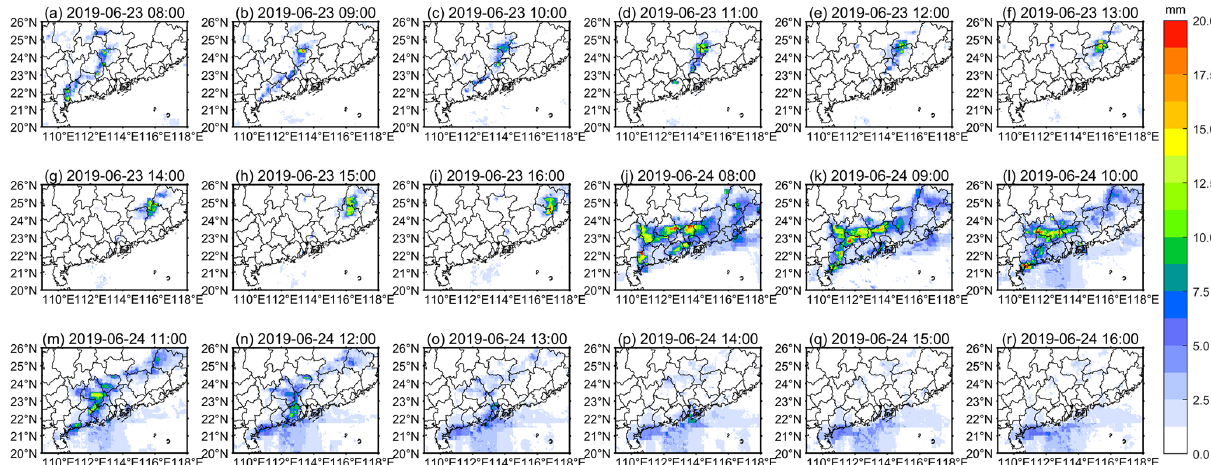
Figure 5. Estimated precipitation of the DQPE algorithm at (a–i) 08:00–16:00CST on 23 June and (j–r) 08:00–16:00CST on 24 June.